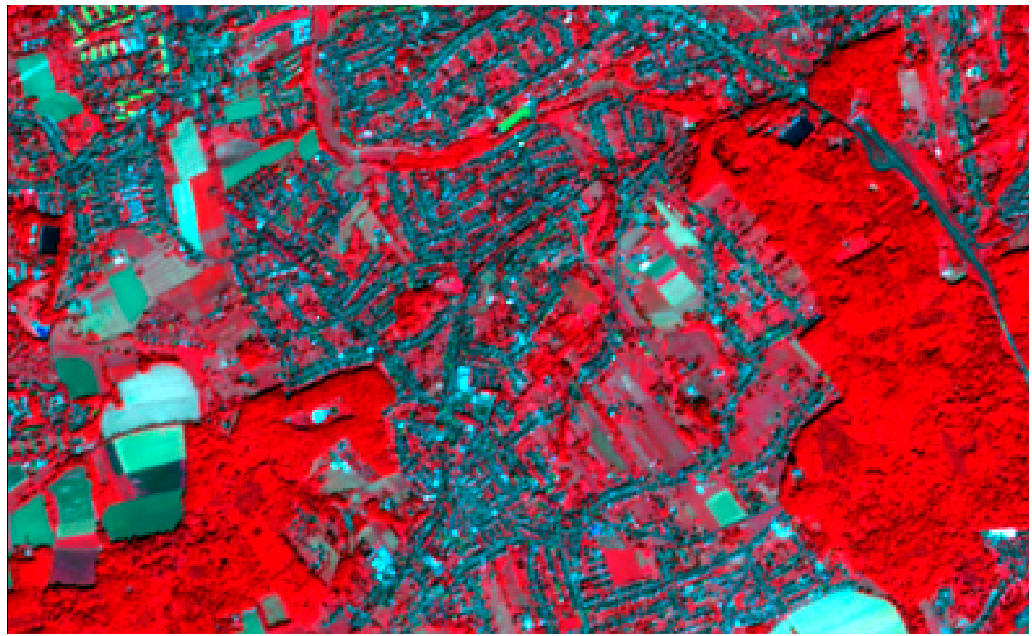
Figure 4. False-color Sentinel-2 satellite image of a part of the city of Dortmund (Germany) acquired on July 24, 2019. The colors red, green blue correspond to the Sentinel-2 wavelengths of band 8 (near infrared), band 4 (red) and band 3 (green) [22].